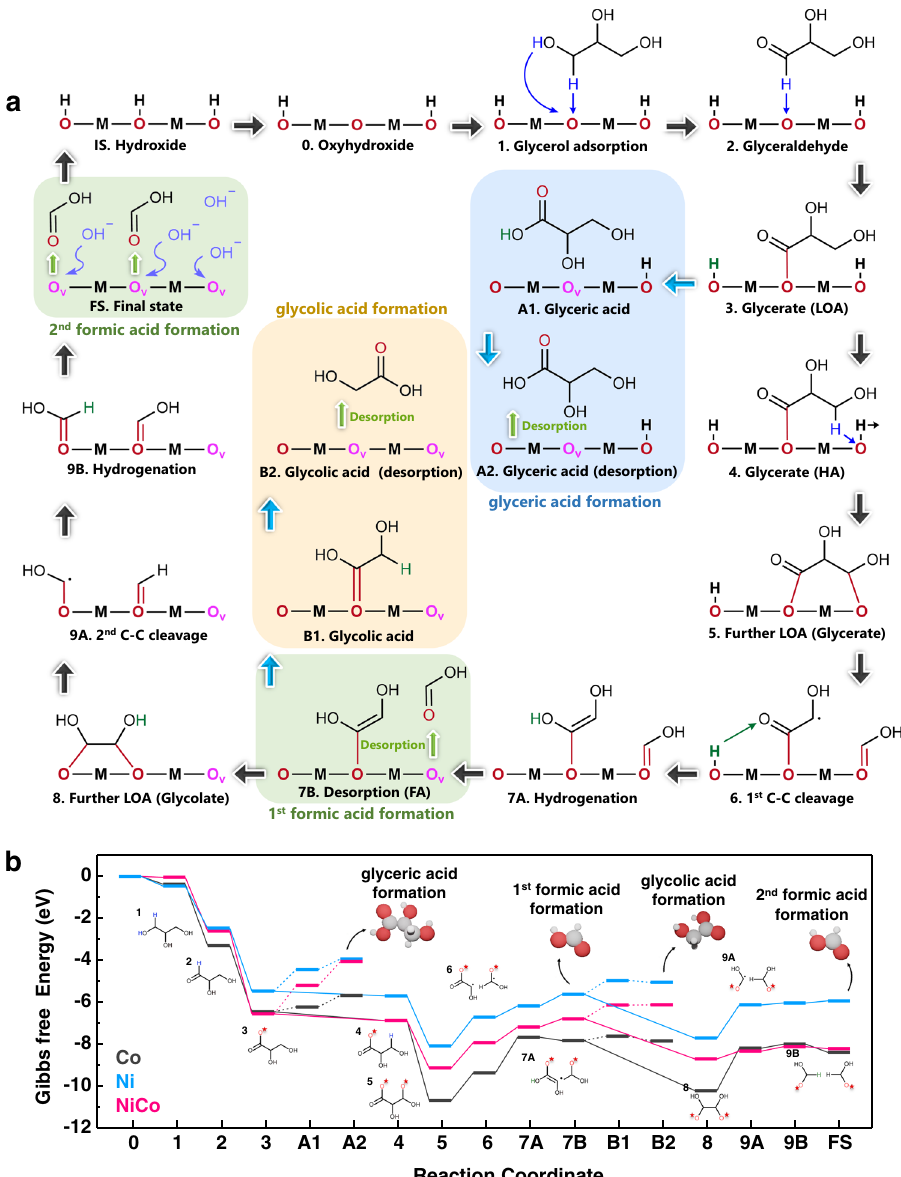
Fig. 2 Theoretical determination of the glycerol oxidation reaction pathway. a Schematic illustration of the glycerol oxidation reaction pathway. The corresponding con fi gurations are shown in Supplementary Figs. 26 – 28. b The calculated Gibbs free energy pro fi les of glycerol oxidation reaction on Ni, NiCo, and Co hydroxide. The numerical data are shown in Supplementary Table